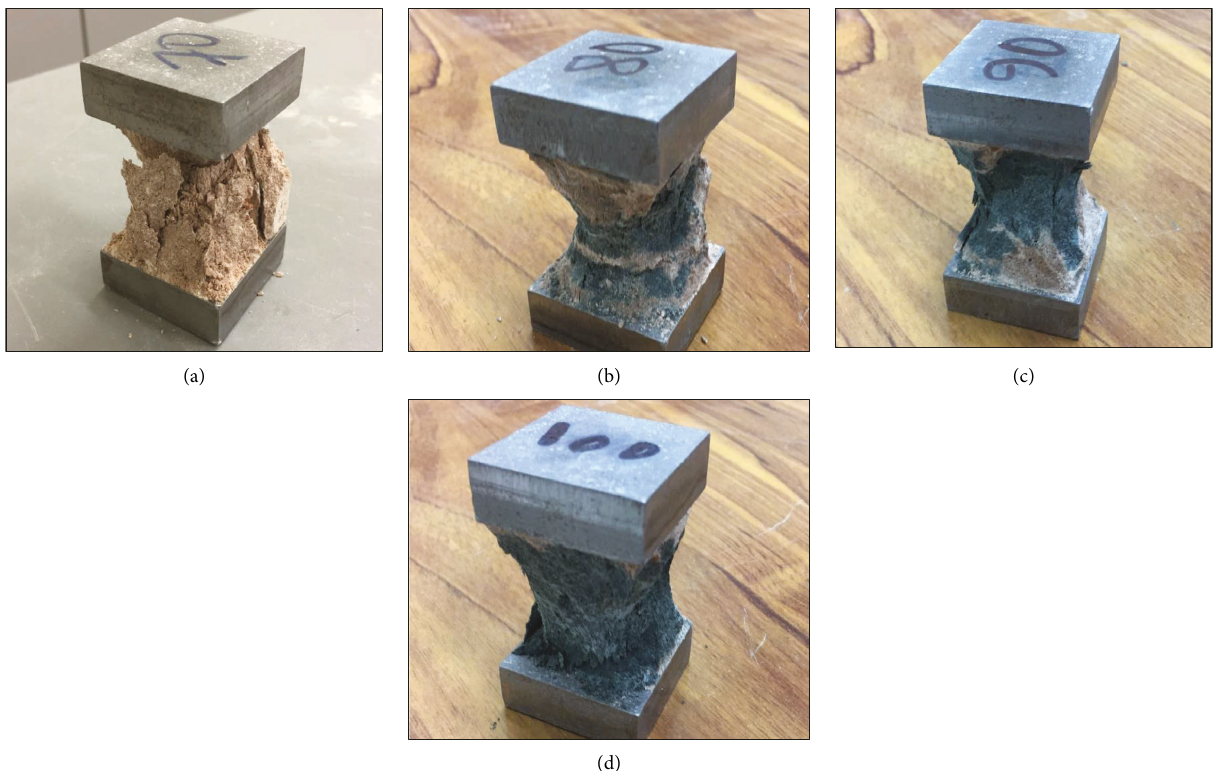
Figure 5: The impact of water amount and super plasticisers on different GGBFS amount mixture’s structure.